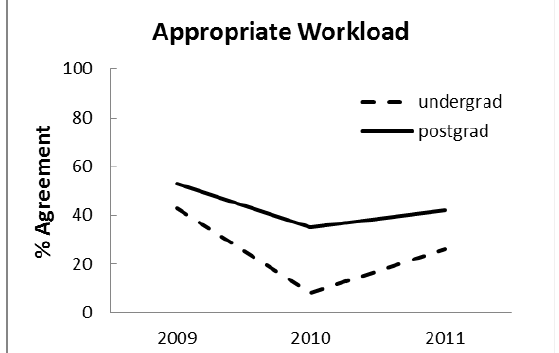
Figure 3. Students' % agreement with the workload being appropriate to achievement of the learning